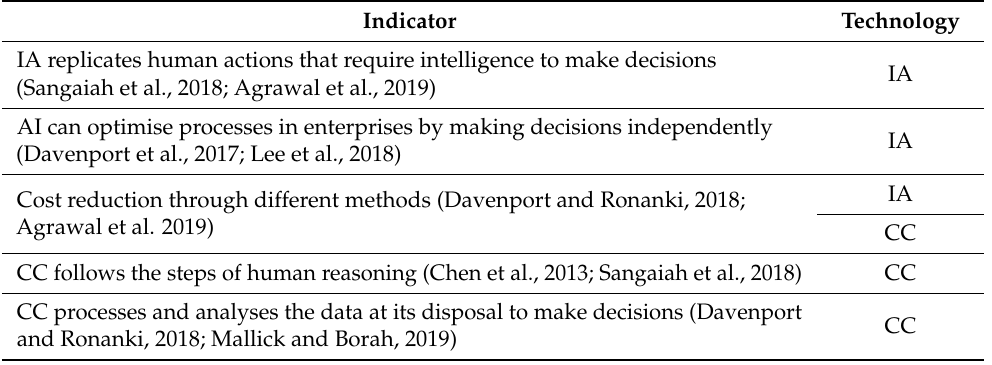
Table 6. Indicators used for objective 3.